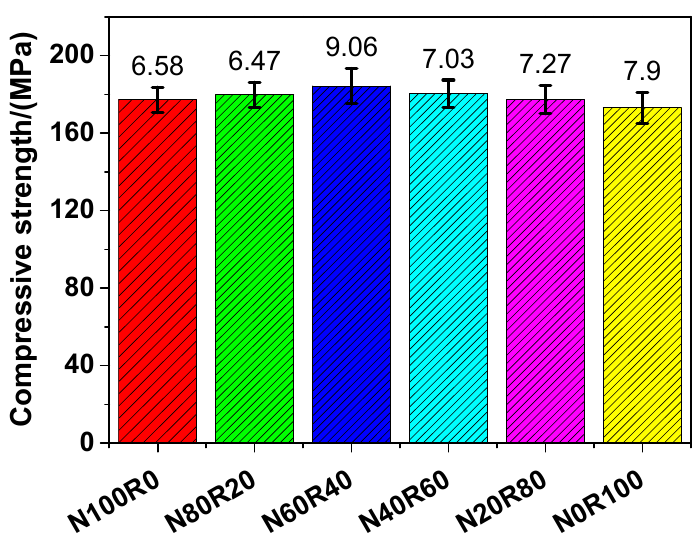
Figure 5. Compressive strength of UHPC.